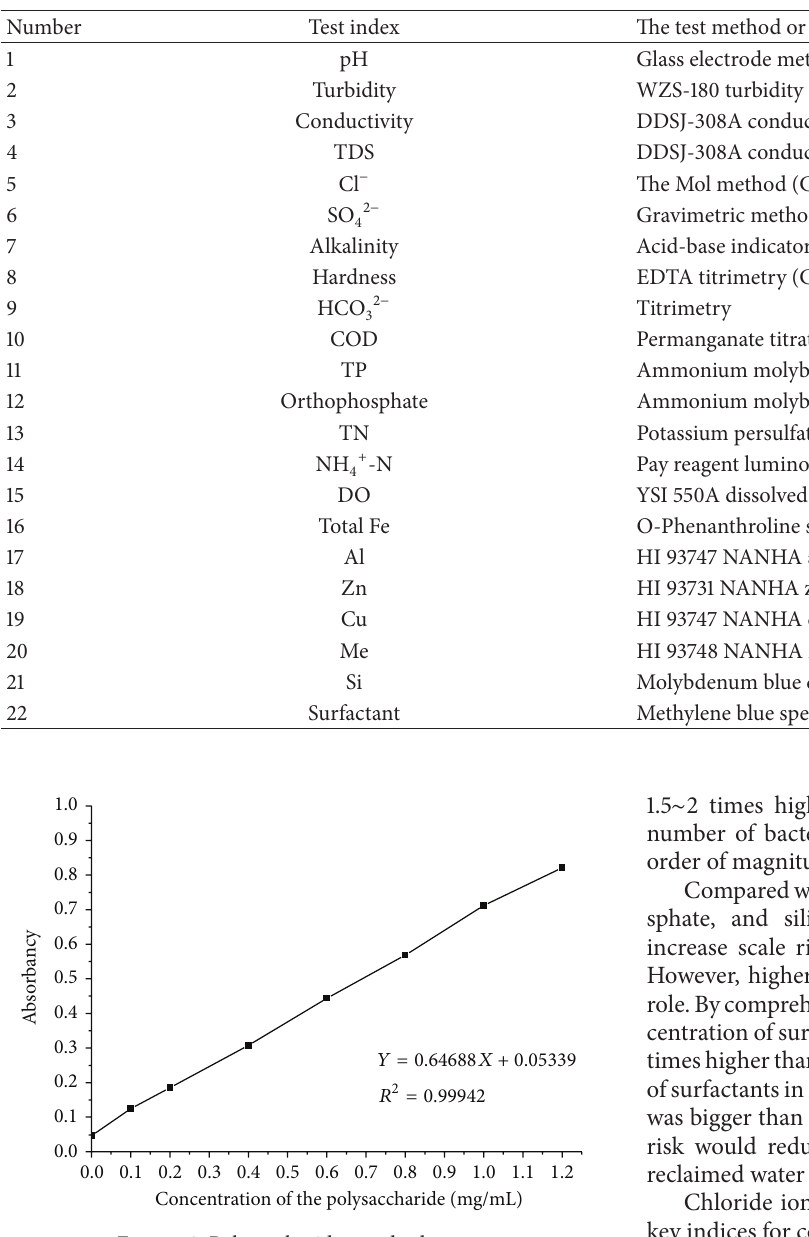
Figure 3: Polysaccharide standard